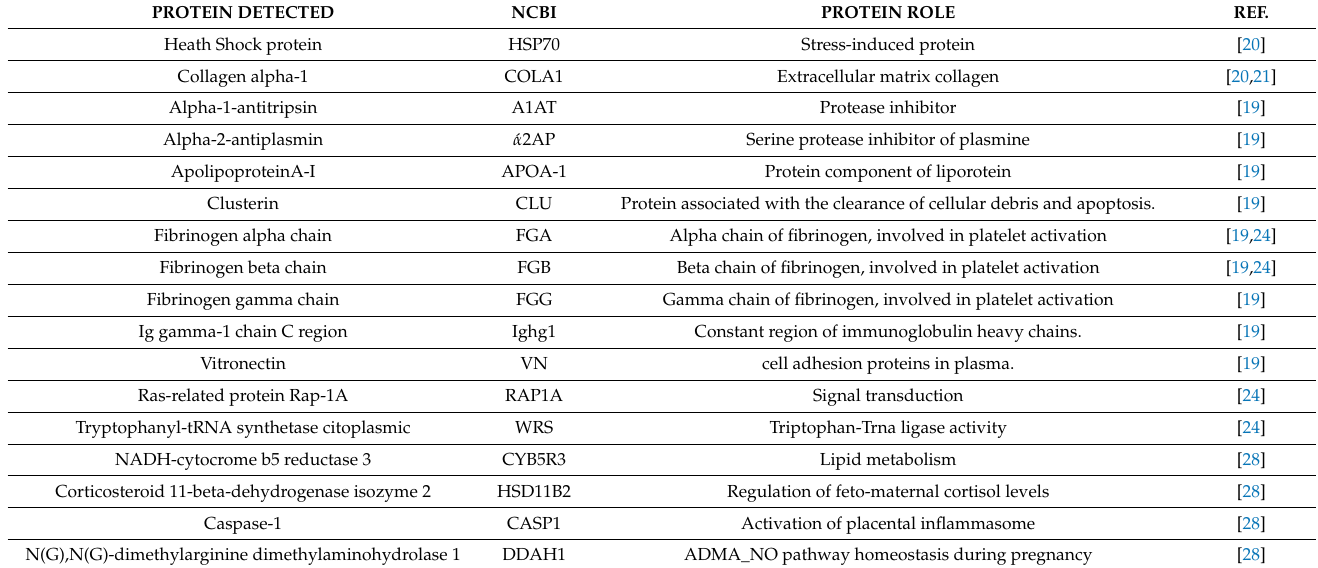
Table 2. List of proteins downregulated in placenta samples of women affected by GDM and their possible